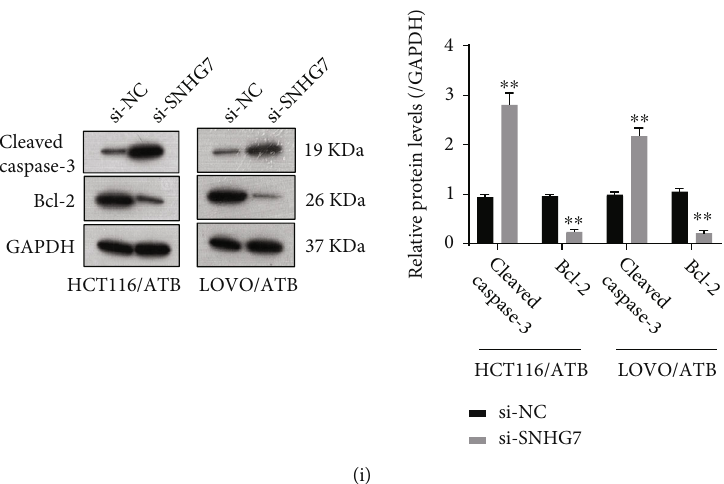
Figure 2: Knockdown of SNHG7 reverses ATB resistance in CRC cells. (a) qRT-PCR revealing the upregulation of SNHG7 in oe-SNHG7 cell lines (HCT116/ATB-oeSNHG7 and LOVO/ATB-oeSNHG7 cell lines). (b) Survival rate of the SNHG7-overexpressing HCT116/ATB and LOVO/ATB cell lines treated with 0, 2, 5, 10, and 20 μ M ATB. (c) CCK8 assay examining the cell viability of oeSNHG7 cell lines. (d) qRT-PCR measurement to check the expression of SNHG7 in siSNHG7 cell lines (HCT116/ATB-siSNHG7 and LOVO/ATB- siSNHG7 knockdown cell lines). (e) Survival rate of HCT116/ATB and LOVO/ATB cell lines with SNHG7 knockdown that are treated with 0, 2, 5, 10, and 20 μ M ATB. (f) CCK8 assay showing the decreased cell viability of siSNHG7 cell lines. (g) Clone-forming ability of HCT116/ATB and LOVO/ATB cell lines with SNHG7 knockdown. (h) Flow cytometric analysis detecting the apoptosis level of siSNHG7 cell lines and the control. Down-regulation of SNHG7 in HCT116/ATB and LOVO/ATB cell lines increases cell apoptosis. (i) Western blot determining the protein level of caspase-3 and Bcl-2. The expression level of caspase-3 was increased, whereas Bcl-2 was decreased in siSNHG7 cell lines. The statistical di ff erences were evaluated by Student ’ s t -test (* P < 0 : 05 , ** P < 0 : 01 , and *** P < 0 : 001